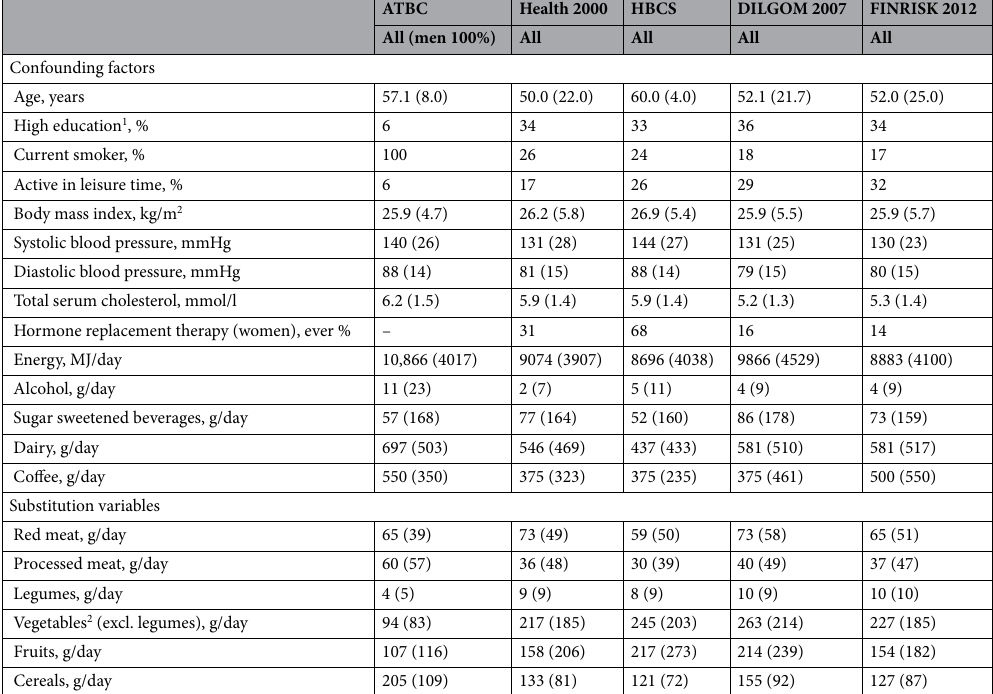
Table 2. Medians (interquartile ranges (IQR)) or percentages of characteristics of participants included in the pooled analysis by cohorts. 1 The total number of school years was divided into birth cohort specific tertiles with the exception of the ATBC study, where ‘highest education’ included those with more than upper secondary education. 2 Nuts and seeds are included in